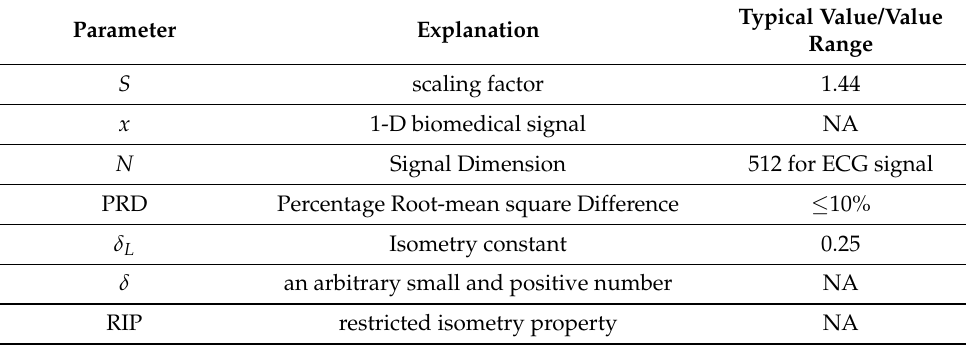
Table 2. List of parameters with their typical